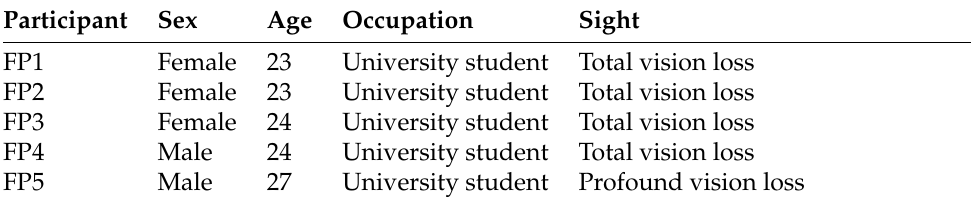
Table 5. Characteristics of blind and visually impaired participants in our formative